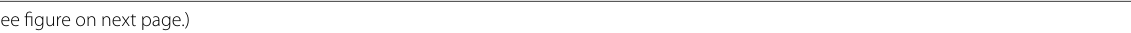
(See figure on next page.) Fig. 3 A Prochilodus magdalenae , developmental cleavage period from (A) 2C: 2‑cell; (B) 4C: 4‑cell; (C) 8C: 8‑cell; (D) 16C: 16‑cell; (E) 32C: 32‑cell to (F) 64C: 64‑cell. B Prochilodus magdalenae , developmental cleavage period from (A) 4C: 4‑cell with the animal pole showing an incomplete division; the cells are dome‑shaped and become increasingly convex toward the vitelline membrane, H&E 4X; (B) 8C: 8‑cell, the blastodisc is characterized to be a clear, yolk‑free region located at the animal pole. The vitellus occupies 75% of the surface area composed of circular and pleomorphic eosinophilic proteinaceous particles with different sizes, H&E 4X; (C) 16C: 16‑cell. The cells have a domed shape with a convex surface, some of them being in the process of active cell division, H&E 40X. Abbreviations: AP: animal pole; B: blastodisc; CD: active cell division; YG: yolk